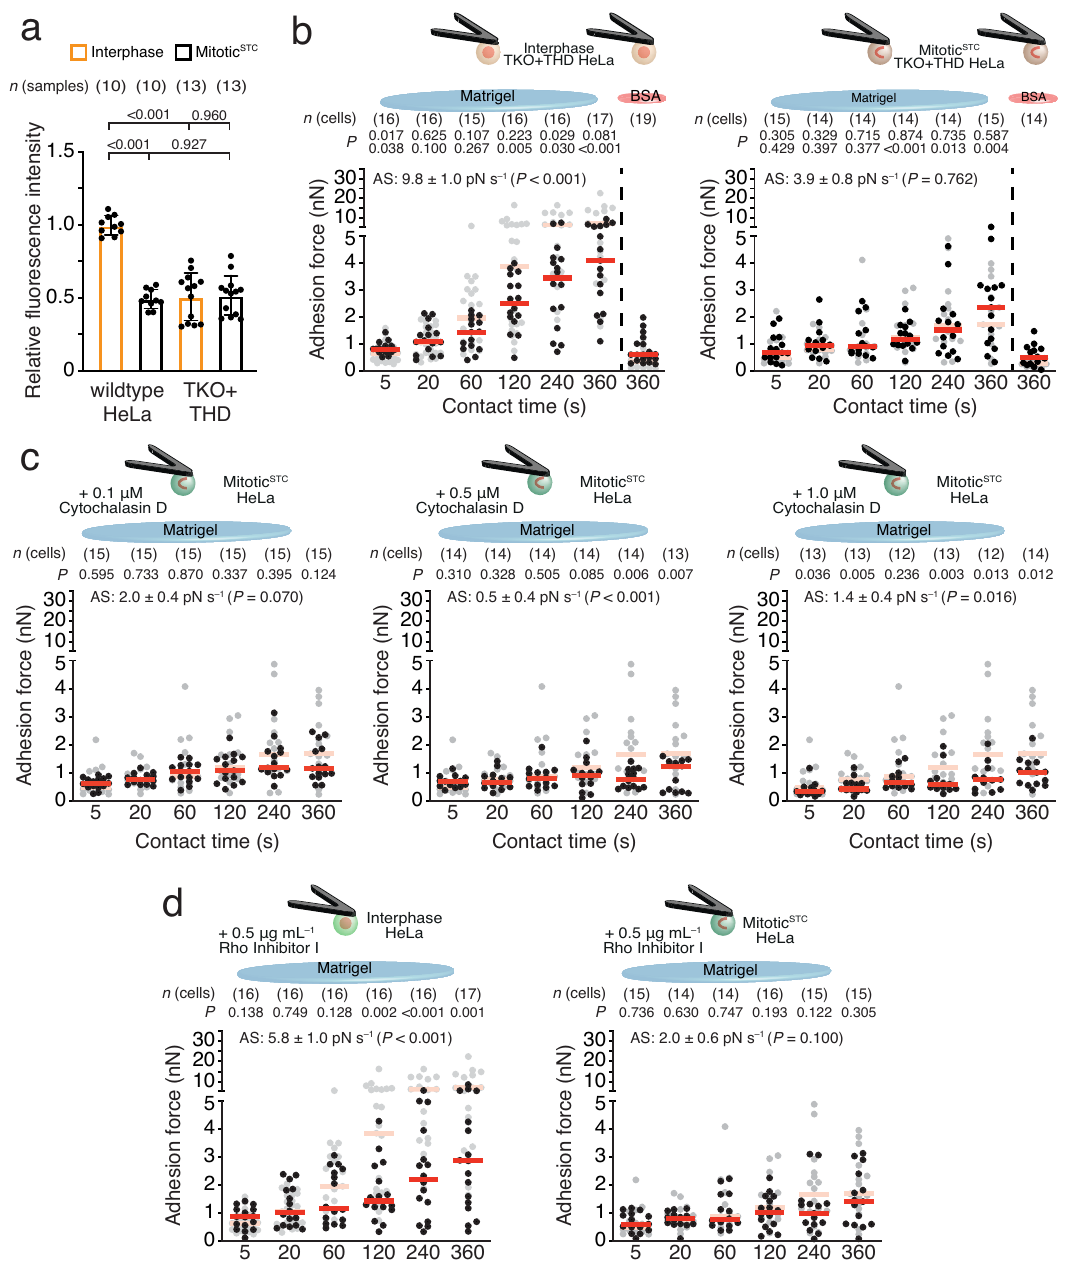
reference data. P values compare displayed data with reference data. For AS-value comparison see Supplementary Fig. 6. Top P values compare displayed data with given reference data, second row P values compare adhesion forces of given data with mitotic STC wildtype (left) and with TKO+THD interphase (right) HeLa cells on Matrigel. c Adhesionforcesofmitotic STC HeLacellsinthepresentsofcytochalasinD inthegivenconcentration. d Adhesionforcesofinterphaseormitotic STC HeLacells inthepresenceofRhoinhibitorI. c , d asreferenceuntreatedHeLacellsaregiven. P valuescomparedisplayedwithreferencedata. P valuescomparingadhesionforces and fl uorescence intensities were calculated using two-tailed Mann – Whitney tests and P values comparing AS-values were calculated by two-tailed extra sum of squares F